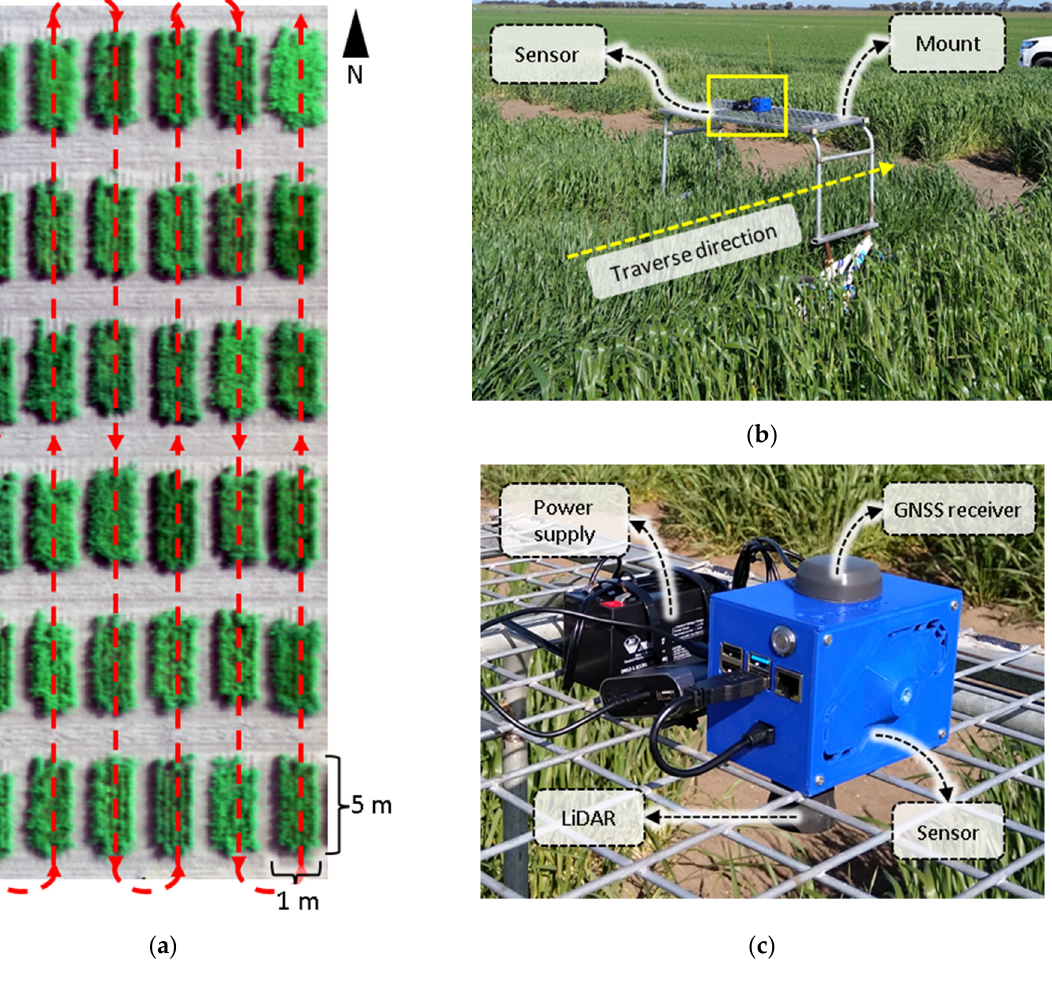
Figure 4. Field experimental and data collection. ( a ) Top view of the field plots, the CropBioMass (CBM) sensor scanned the plots in the trajectory that is specified in red, ( b ) the mobile vehicle mount for the CBM sensor that was used in the experiment and its traverse direction, and ( c ) a close-up view of the CBM sensor hardware highlighting the LiDAR, GNSS receiver, and the power supply